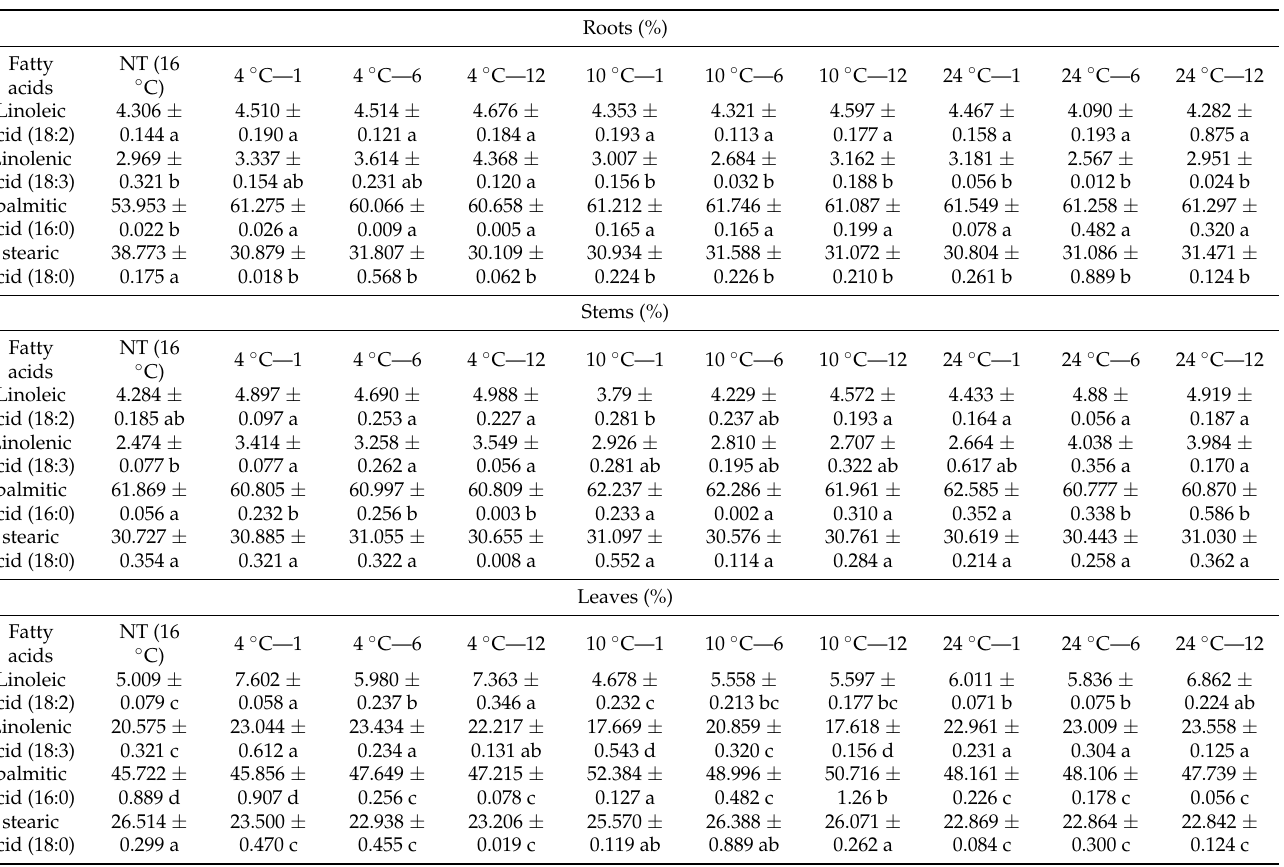
Table 1. Effect of different temperatures on the composition and contents of fatty acids in safflower different